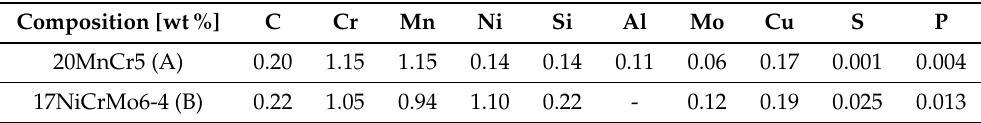
Table 1. Composition of main alloying elements (wt% > 0.1) as well as S and P before LPC. Composition [wt%] C Cr Mn Ni Si Al Mo Cu